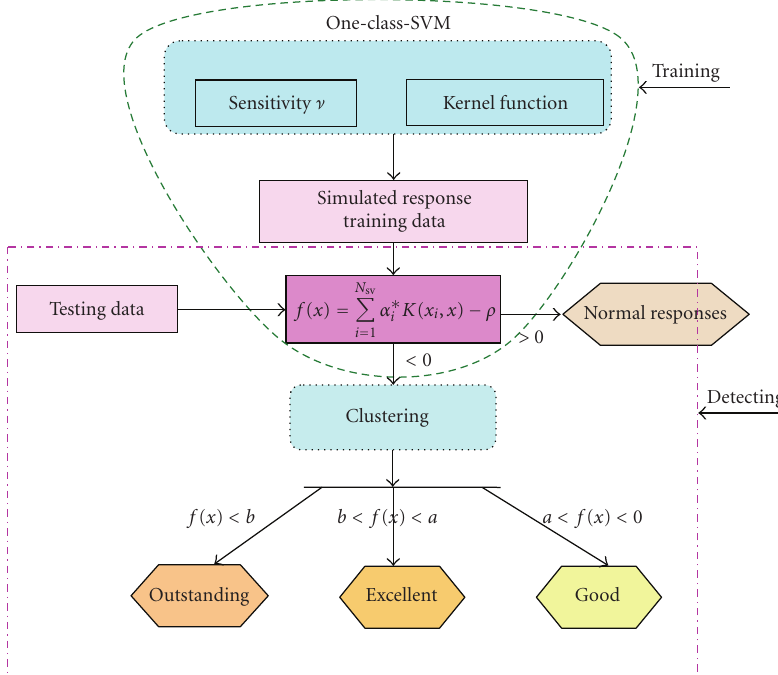
Figure 2: Structural illustration of the SVM-based AI interaction